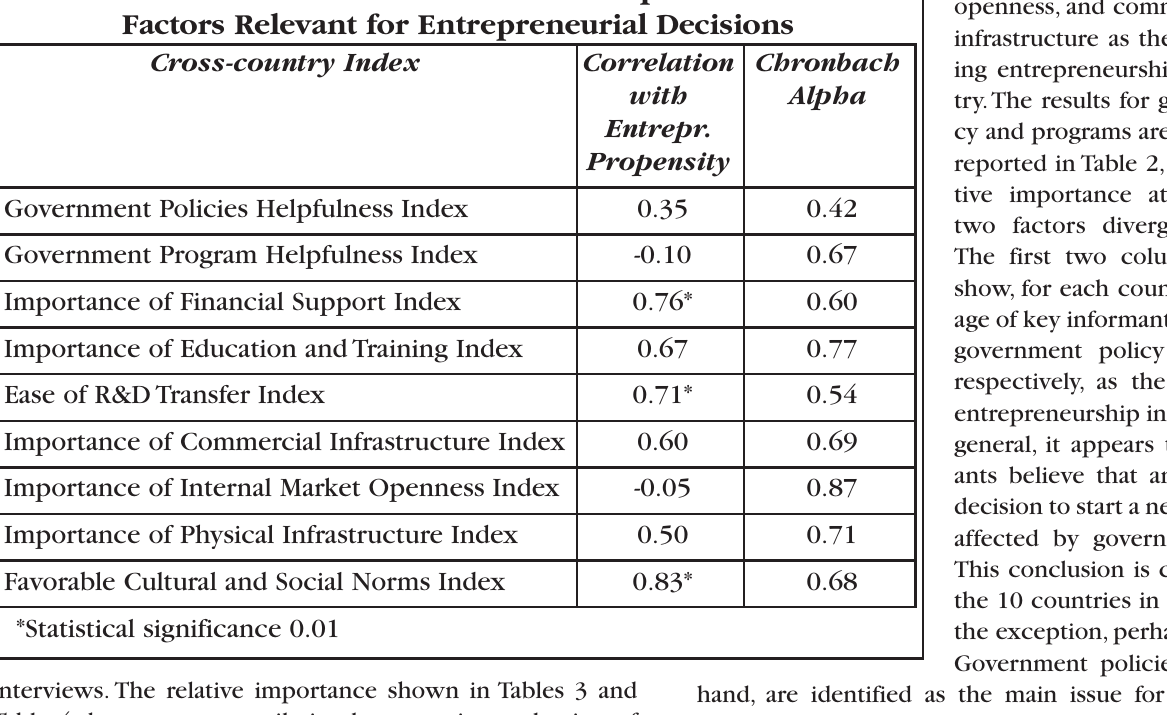
Table 2. Correlation Between Start-up Rate and Factors Relevant for Entrepreneurial